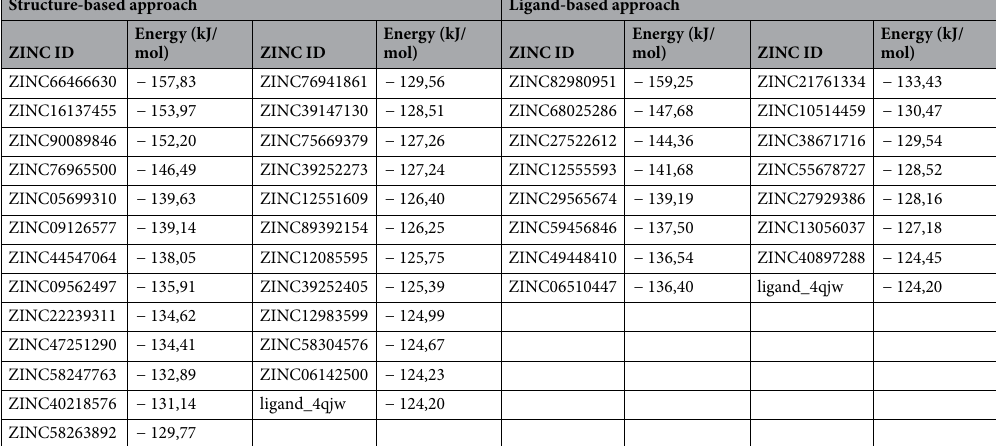
Table 1. Binding energies of the top “purchasable” compounds after re-scoring using MM-GBSA.